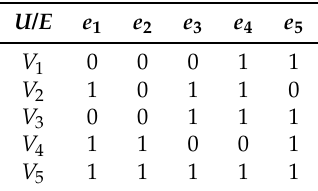
Table 3. Standard representation of a soft set ( F, E